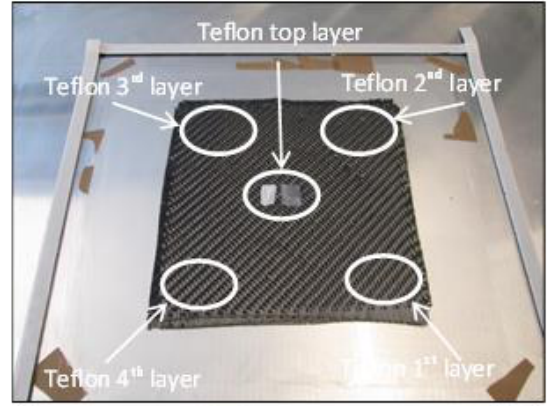
Figure 4. Test specimen, first thermography